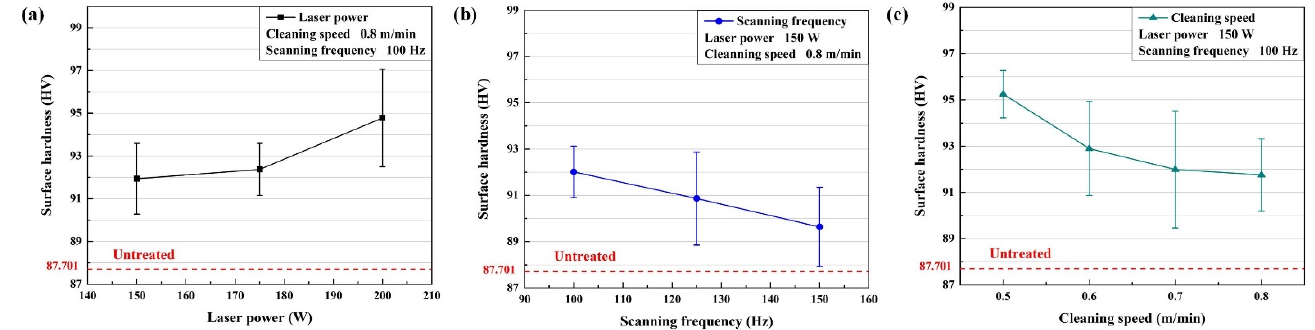
Figure 7. The variation of the surface hardness with the process parameters: ( a ) laser power; ( b ) scanning frequency; ( c ) cleaning speed. ( b ) scanning frequency; ( c ) cleaning speed.